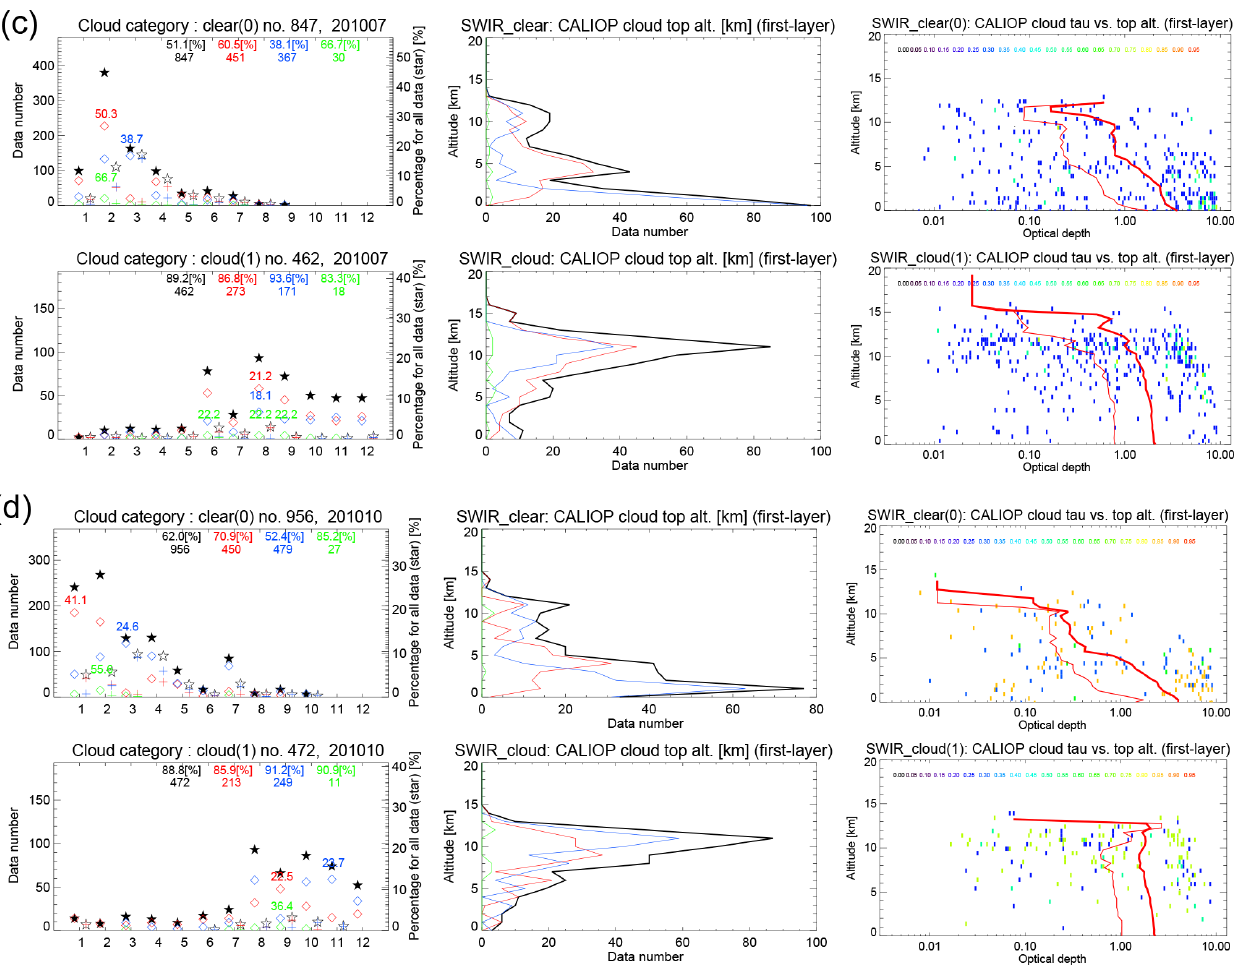
Figure 7. (a) The upper (lower) rows show the results for clear (cloud) flags from TANSO-FTS derived by the water vapor saturated method in January 2010. The left column is made up of histograms of the 12 spectral groups. The closed star indicates the whole dataset, and open diamonds indicate values over land (red), ocean (blue) and open water (green). The open star and cross (+) show the histogram for data that did not match CALIOP cloud flags. The values at the top of the panels show the matching ratio with CALIOP. The values near the red and blue diamonds show the highest percentage within land and ocean, respectively. The middle column represents the distribution of cloud top altitude from CALIOP. The black, red, blue and green lines show the whole dataset, land, ocean and open water, respectively. The distance between TANSO-FTS and CALIOP is 100km. The right-hand column represents the probability density distribution of the log-scale optical thickness from CALIOP as a function of altitude. The red thick (thin) line shows the average (median) of optical thickness at each altitude. The number at the top of the panels indicates the percentage of probability density. (b) Same as (a) but for April 2010. (c) Same as (a) but for July 2010. (d) Same as (a) but for October